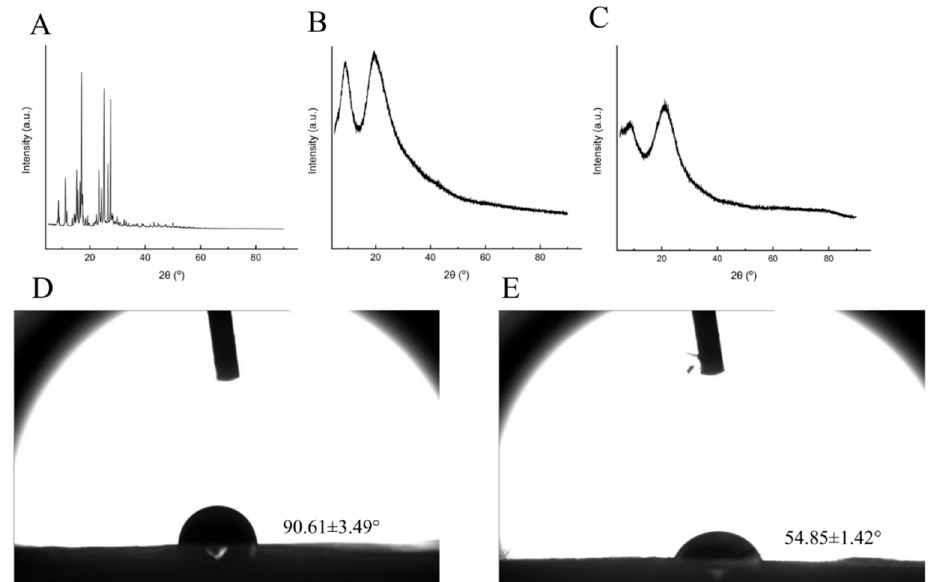
Figure 3. ( A ) X-ray diffraction patterns of methyl ferulate electrospinning fibers. ( B ) X-ray diffraction patterns of zein electrospinning fibers. ( C ) X-ray diffraction patterns of methyl ferulate/zein electrospinning fibers. ( D ) WCA of zein electrospinning fibers. ( E ) WCA of methyl ferulate/zein electrospinning fibers.